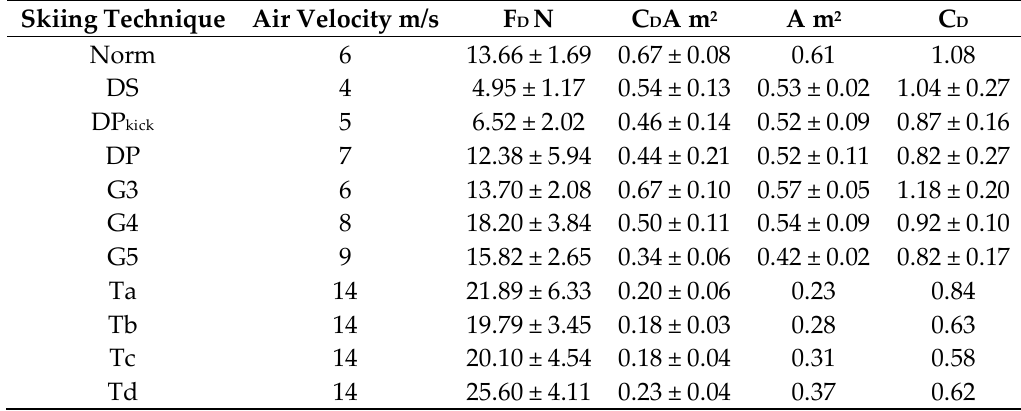
Table 1. Results (mean ± SD) of air drag (F D ), drag area (C D A), projected frontal area (A) and coefficient of drag (C D ) for different classical and free style cross-country skiing techniques. Norm is the skier standing in a normal upright